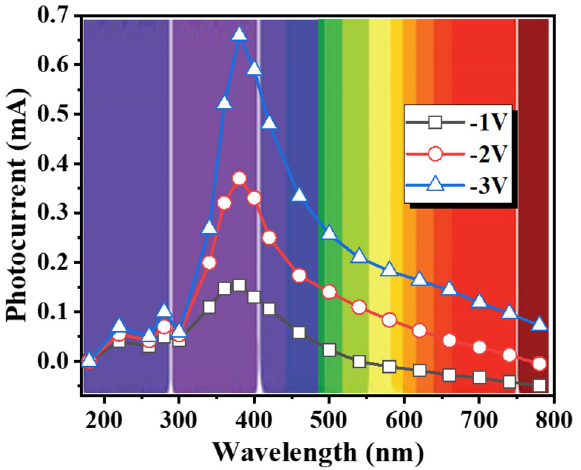
Figure 8. Spectral response characteristic of GaN-NTs based UV-PD from 200 to 800 nm under applied